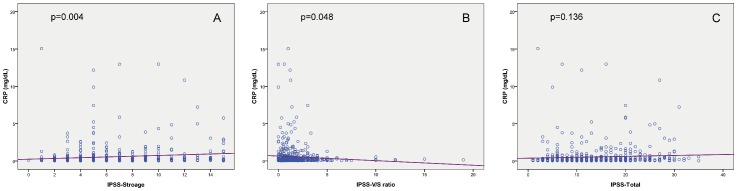
The serum CRP levels are significantly correlated with (A) storage IPSS and (B) IPSS V/S ratio, but not with (C) total IPSS.